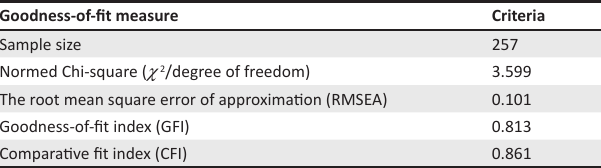
TABLE 3: Goodness-of-fit indices for the structural model transformational leadership.